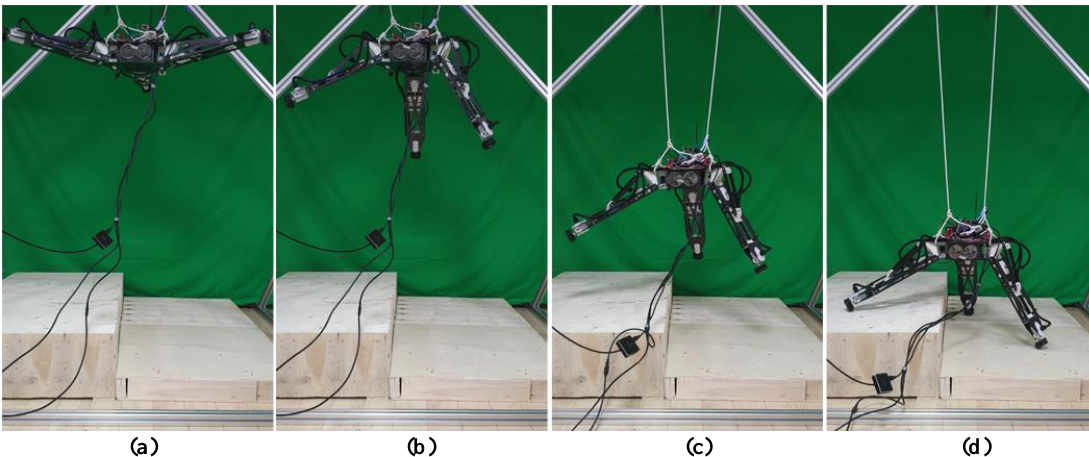
Figure 11. Adaptive landing process: ( a ) Initialization, ( b ) adjustment, ( c ) descend, ( d ) completeness.